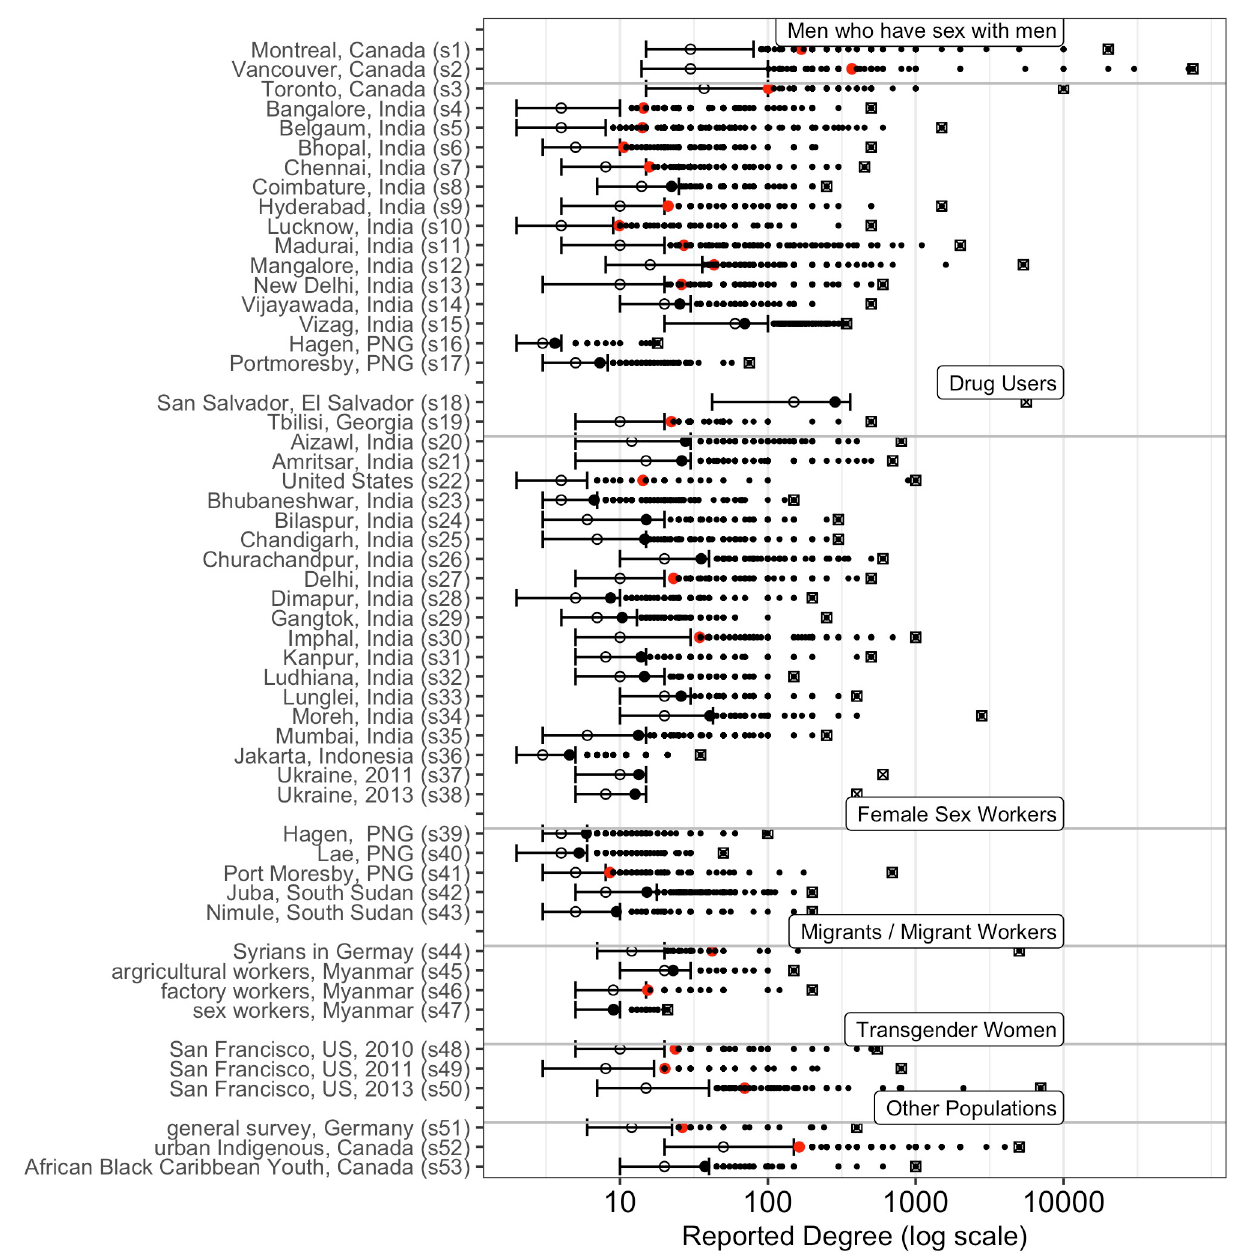
Fig 1. Reported degree distributions across samples. Distribution of reported degree across all samples from various target populations. Bars delineate the interquartile range, the mean is represented by a filled red circle, the median by an open circle and the maximum reported degree by a square box. Small dots indicate all reports above the interquartile